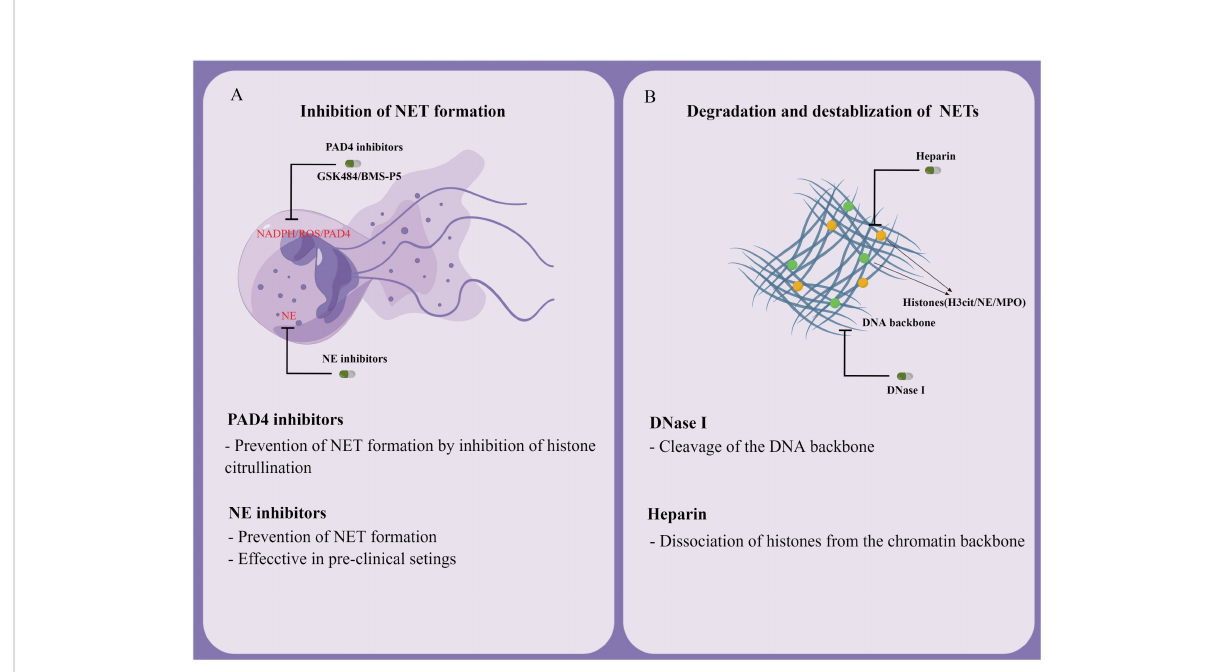
FIGURE 5 Potential therapeutic targets for NETs. (A) Inhibition of NET formation. (B) Degradation and destabilization of already formed